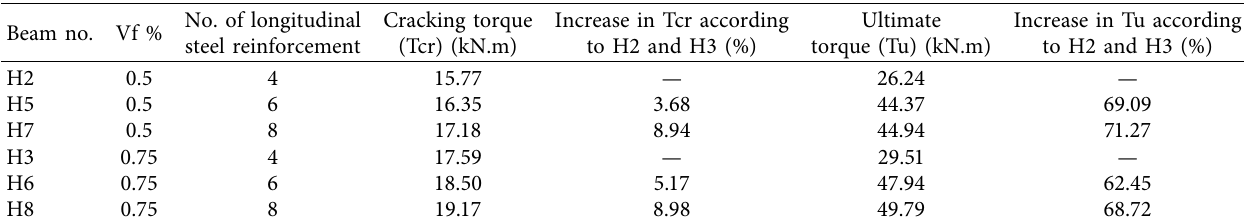
Table 11: Effect of the main reinforcement number on cracking and ultimate torsional